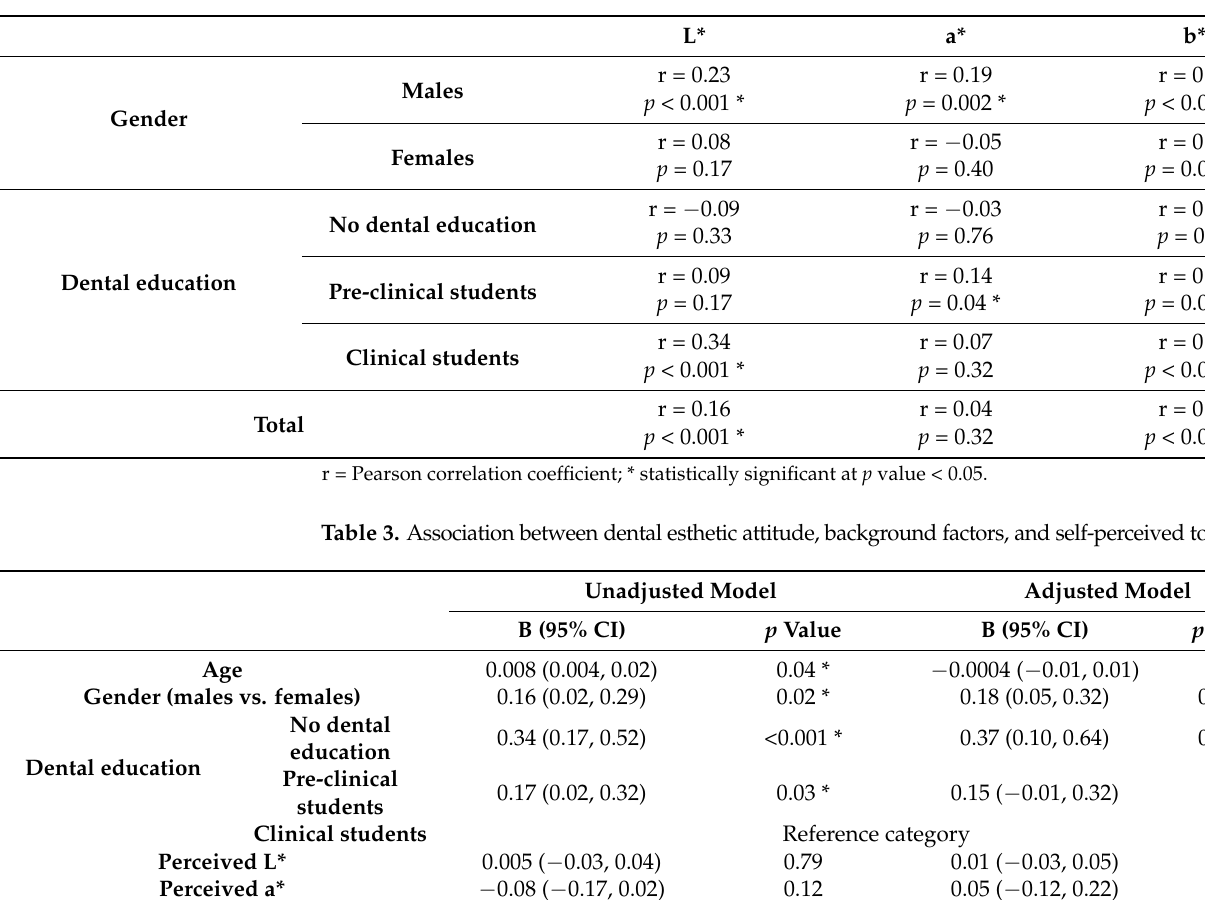
Table 2. Correlation between perceived and actual digital shade (color coordinates).